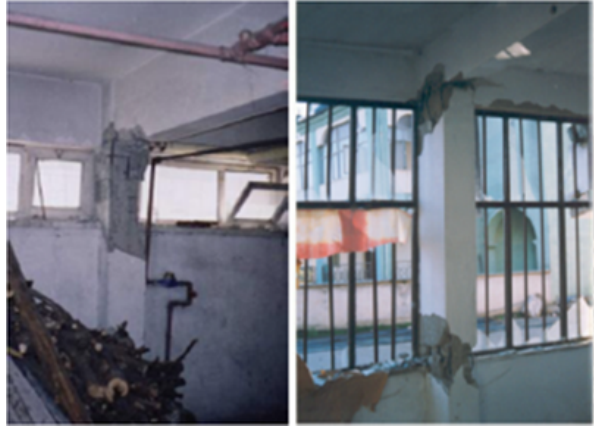
Figure 7. Short column formation caused by ribbon windows (METU/EERC,